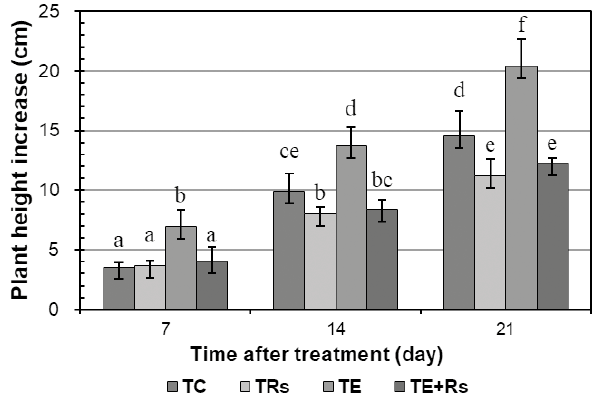
Figure 7. Height (cm) of tomato plants, with or without inoculation of Rhizoctonia solani , after treatment with Euphorbia hirta ethanol extract, for plants measured at 7, 14 or 21 days after treatment. TC: Negative control, sprayed with water; TRs: positive control, inocu- lated with R. solani ; TE: Plants treated with E. hirta extract; TE+Rs: Plants treated with E. hirta extract and inoculated with R. solani . Values are means ± standard deviation, calculated for 30 plants per treatment. Values accompanied by different letters are significantly different, according to ANOVA paired with Tukey’s tests ( P ≤ 0.05).